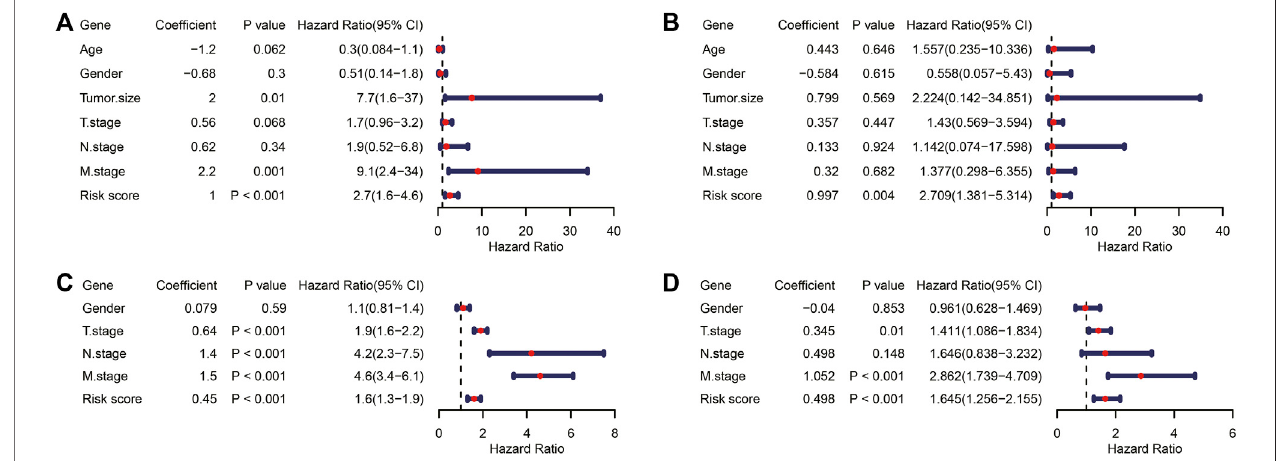
FIGURE 9 | TIR-lncRNA signature was an independentprognostic factor for RCC. (A,B) The Forest plot showed the results of univariate Coxand multivariate Cox regression analyses in the training set. (C,D) The Forest plot showed the results of univariate Cox and multivariate Cox regression analyses in the testing set.